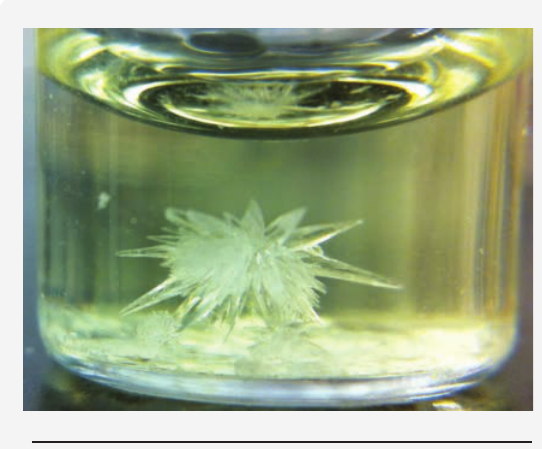
Figure 5. Crystallization of ribose aminooxazoline (RAO). 2AO reacts with glyceraldehyde to form RAO, a precursor of the pyrimidine nucleo- tides, but the arabinose, lyxose and xylose aminooxazolines are also formed. Only RAO crystallizes from the reaction mixture. Adapted from Hein, Tse and Blackmond, Nat. Chem., 2011.